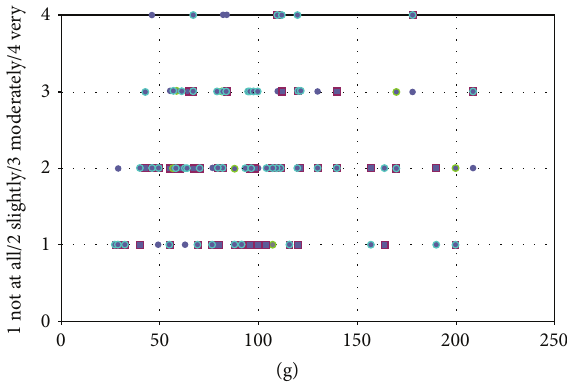
Figure 12: Dermoglandular rotation flap: correlation between resection volume and difference in the breast volume (subjective rating of the expert